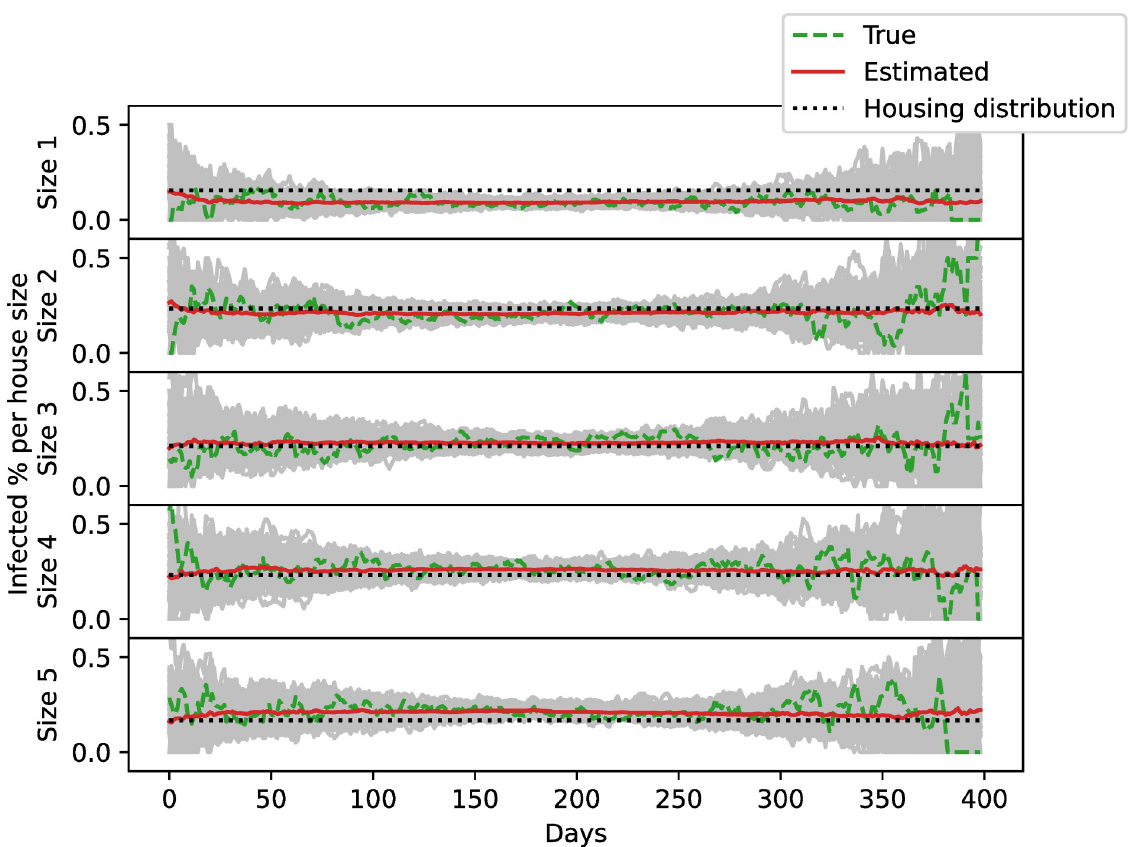
Fig 5. Relative amount of infected agents per house size as a function of time. Ensemble members plotted with gray and their mean with red. The true values are represented with green dashed lines. Dotted black lines indicate the distribution of agents in different house sizes regardless of their disease